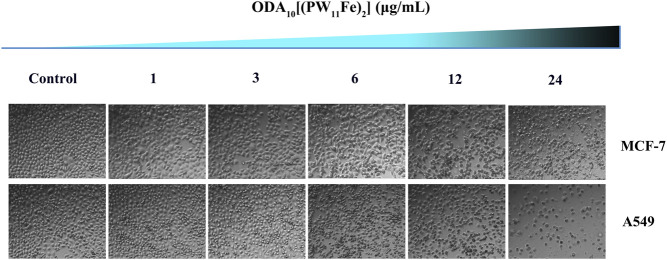
Morphological changes of MCF-7 and A549 cells induced by different concentration of ODA10[(PW11Fe)2] for 24 h.